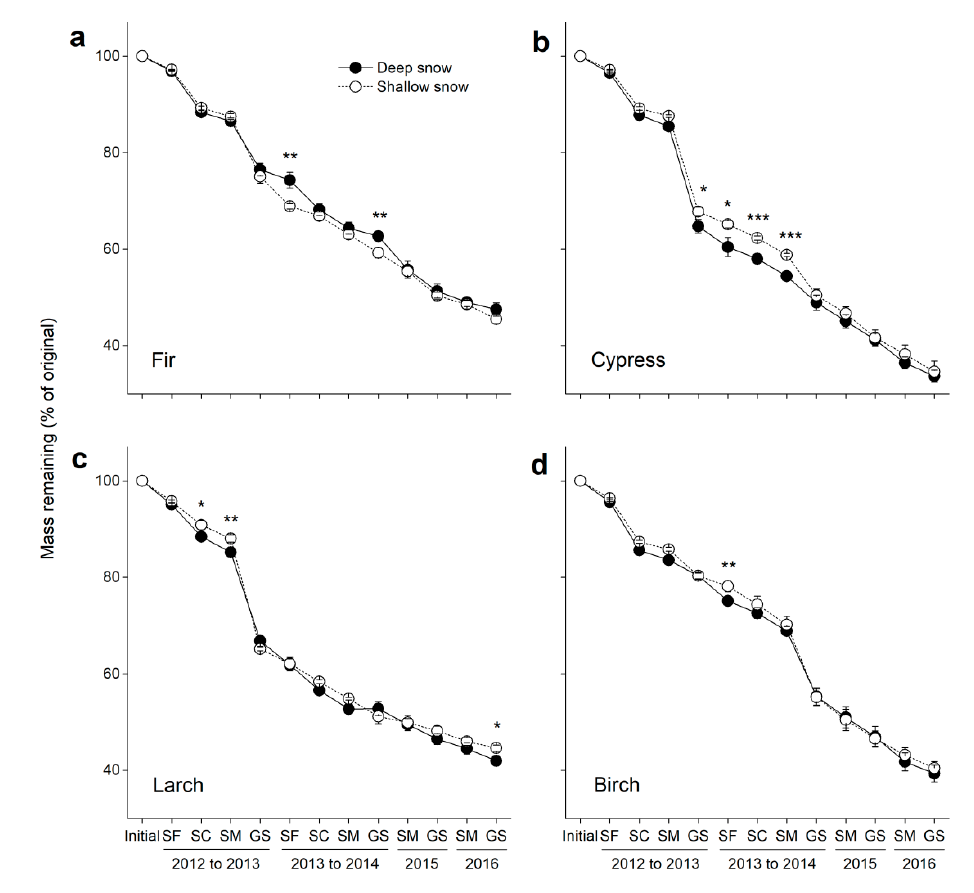
Figure 2. Mass remaining in decomposing litter in the deep and shallow snow plots. ( a ) Fir, ( b ) cypress, ( c ) larch, and ( d ) birch. SF: snow formation stage, SC: snow coverage stage, SM: snowmelt stage, and GS: growing season. * p < 0.05, ** p < 0.01 and *** p < 0.001.